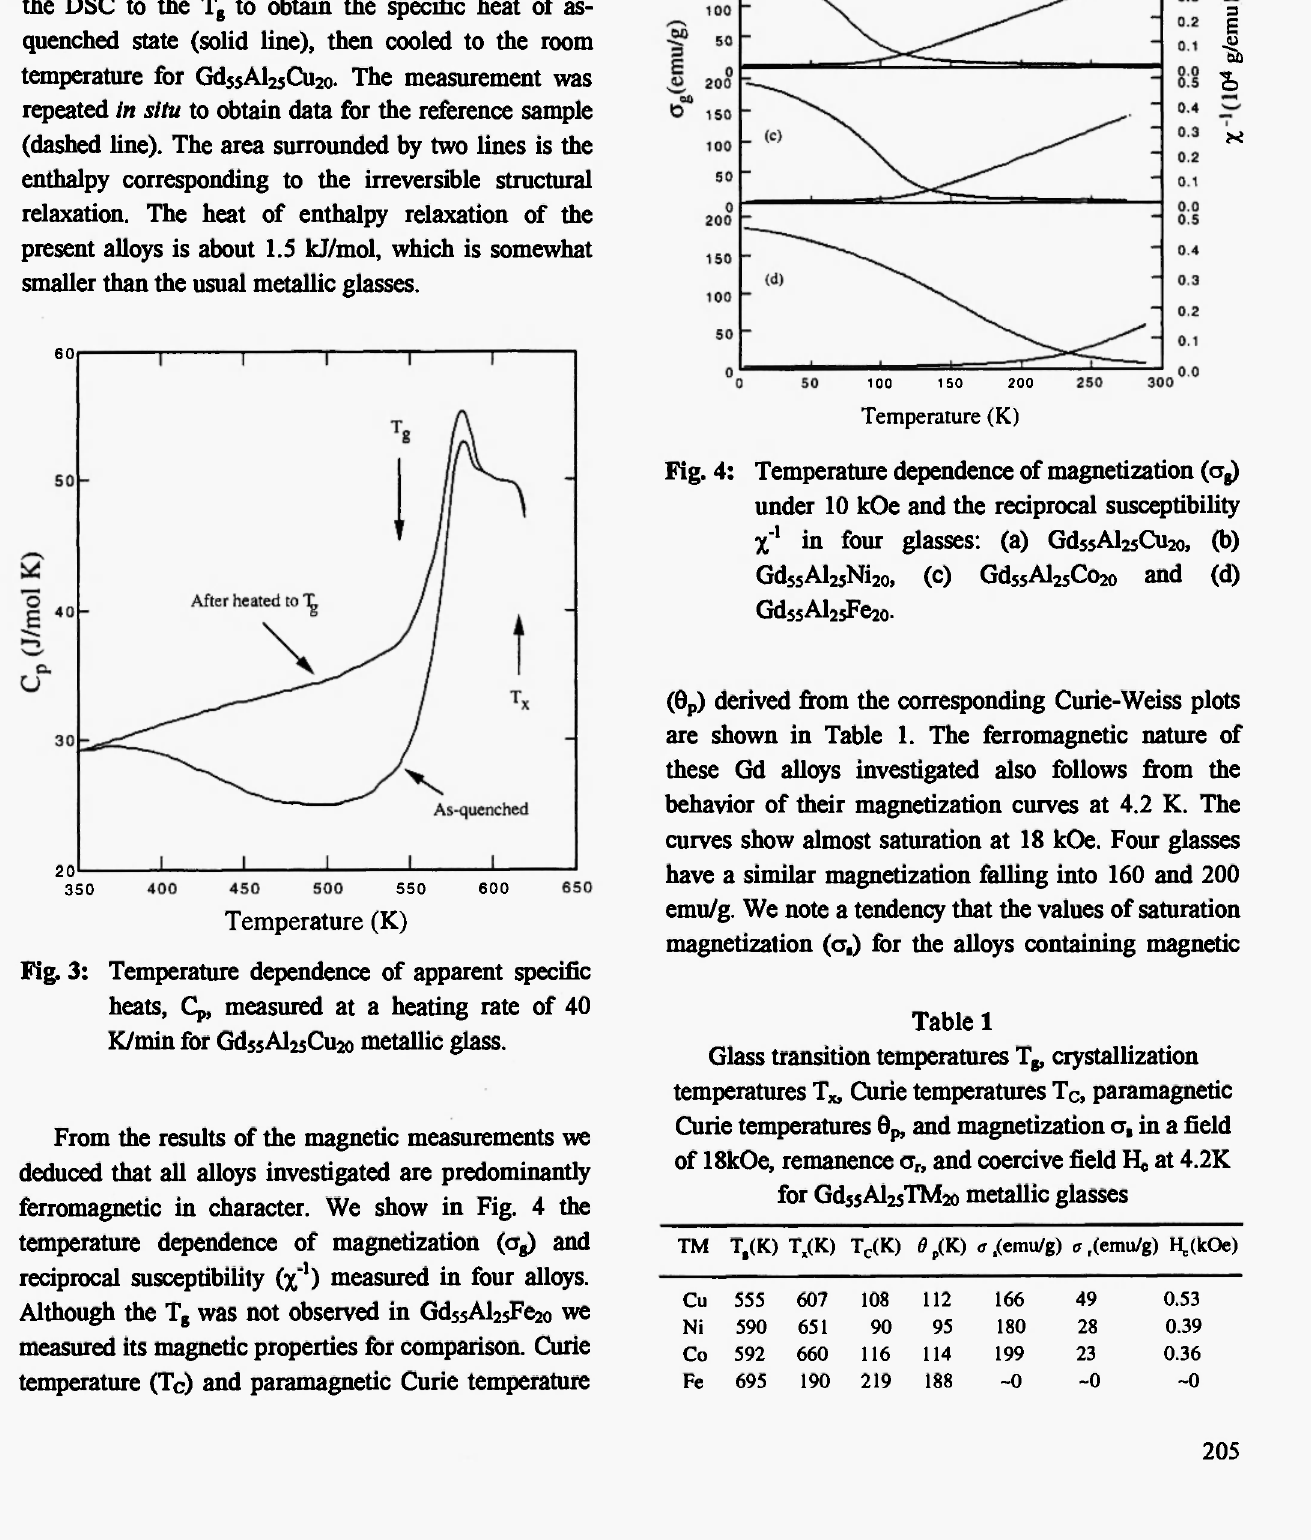
Fig. 4: Temperature dependence of magnetization (ag) under 10 kOe and the reciprocal susceptibility χ" 1 in four glasses: (a) GdssAl^Ouko, (b) Gd5 Al2jNi2o, (c) GdssAl^CoM and (d) 5 Gd55Al2sFe2o- (θ ) derived from the corresponding Curie-Weiss plots ρ are shown in Table 1. The ferromagnetic nature of these Gd alloys investigated also follows from the behavior of their magnetization curves at 4.2 K. The curves show almost saturation at 18 kOe. Four glasses have a similar magnetization falling into 160 and 200 emu/g. We note a tendency that the values of saturation magnetization (σ.) for the alloys containing magnetic Glass transition temperatures Tg, crystallization temperatures T , Curie temperatures T paramagnetic x C) Curie temperatures θρ, and magnetization σ, in a field of 18kOe, remanence σ , and coercive field H at 4.2K Γ for Gdj$Al25TM2o metallic